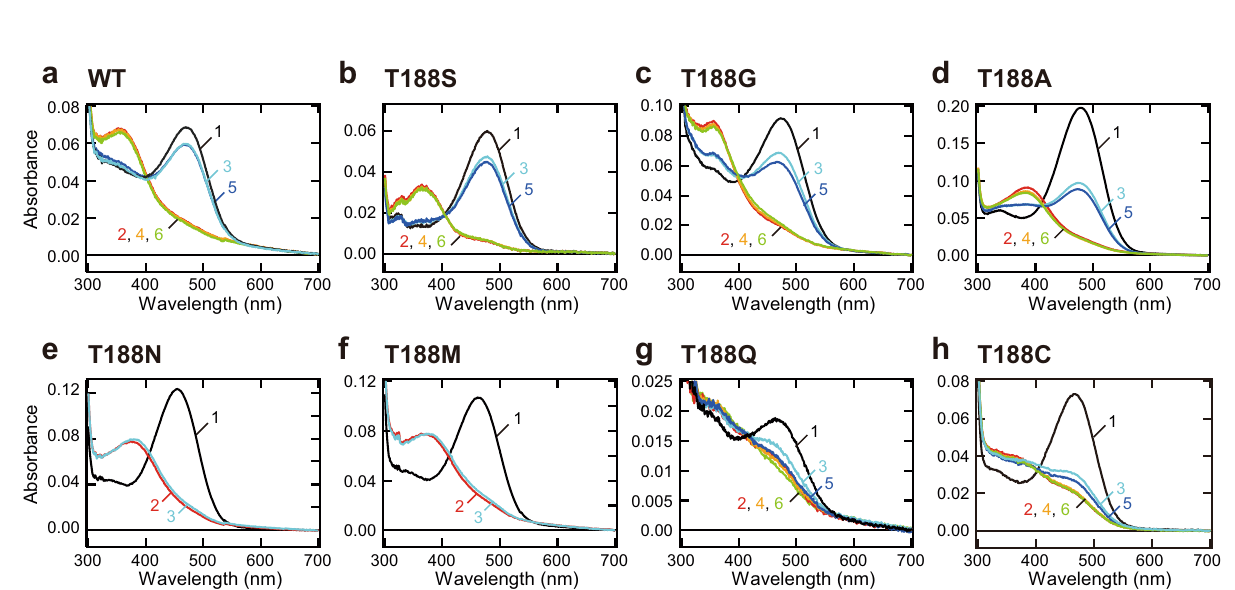
Fig. 3 Spectral changes of wild-type and Thr188 mutant Opn5m proteins. Absorption spectra of Opn5m wild-type ( a ) and T188S ( b ), T188G ( c ), T188A ( d ), T188N ( e ), T188M ( f ), T188Q ( g ), and T188C ( h ) mutant proteins puri fi ed after the addition of all- trans retinal to the medium of the transfected cultured cells. The spectra were recorded at 0 °C in the dark (curve 1), after yellow light (>500 nm) irradiation (curve 2), after subsequent UV light (360 nm) irradiation (curve 3), after yellow light re-irradiation (curve 4), after UV light re-irradiation (curve 5) and after yellow light re-irradiation (curve 6). Spectral changes by each light irradiation are shown in Supplementary Fig.